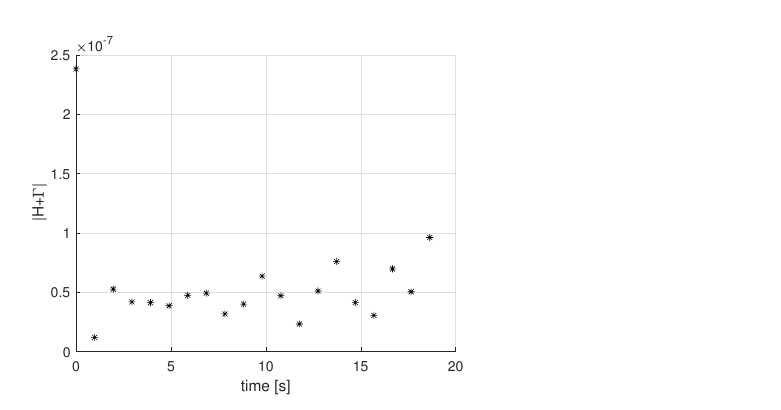
Figure 5. Hamiltonian loss for the unconstrained intercept problem with penalty Γ = 10 ( N = 20 and L =